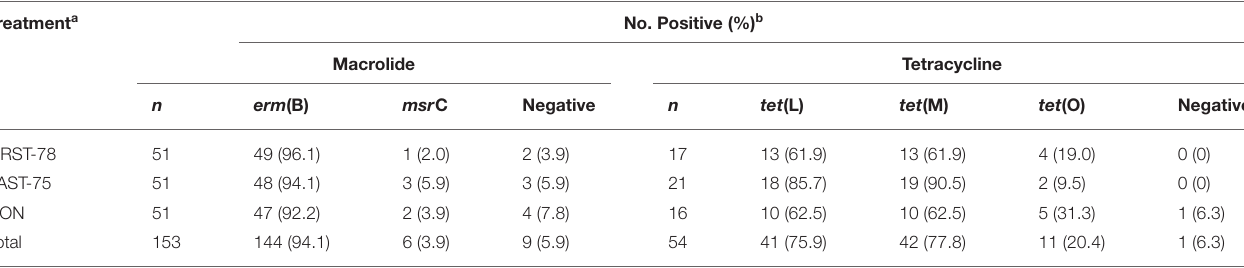
TABLE 3 | Distribution of enterococci isolates from feedlot cattle feces grouped according to macrolide ( n = 153) and tetracycline ( n = 54) resistance genes and by cattle fed tylosin for the FIRST-78% , LAST-75% , or continuously ( CON ) during the feeding period. Treatment